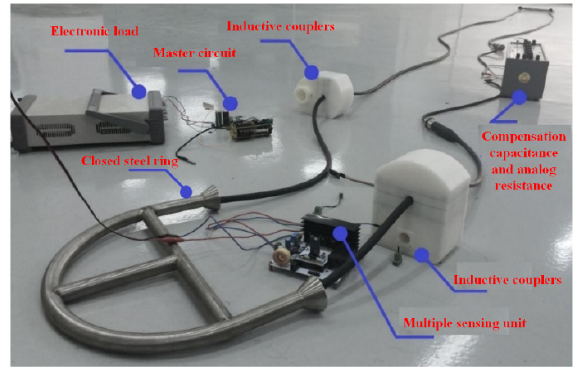
Figure 8. The power feeding and data transmission test